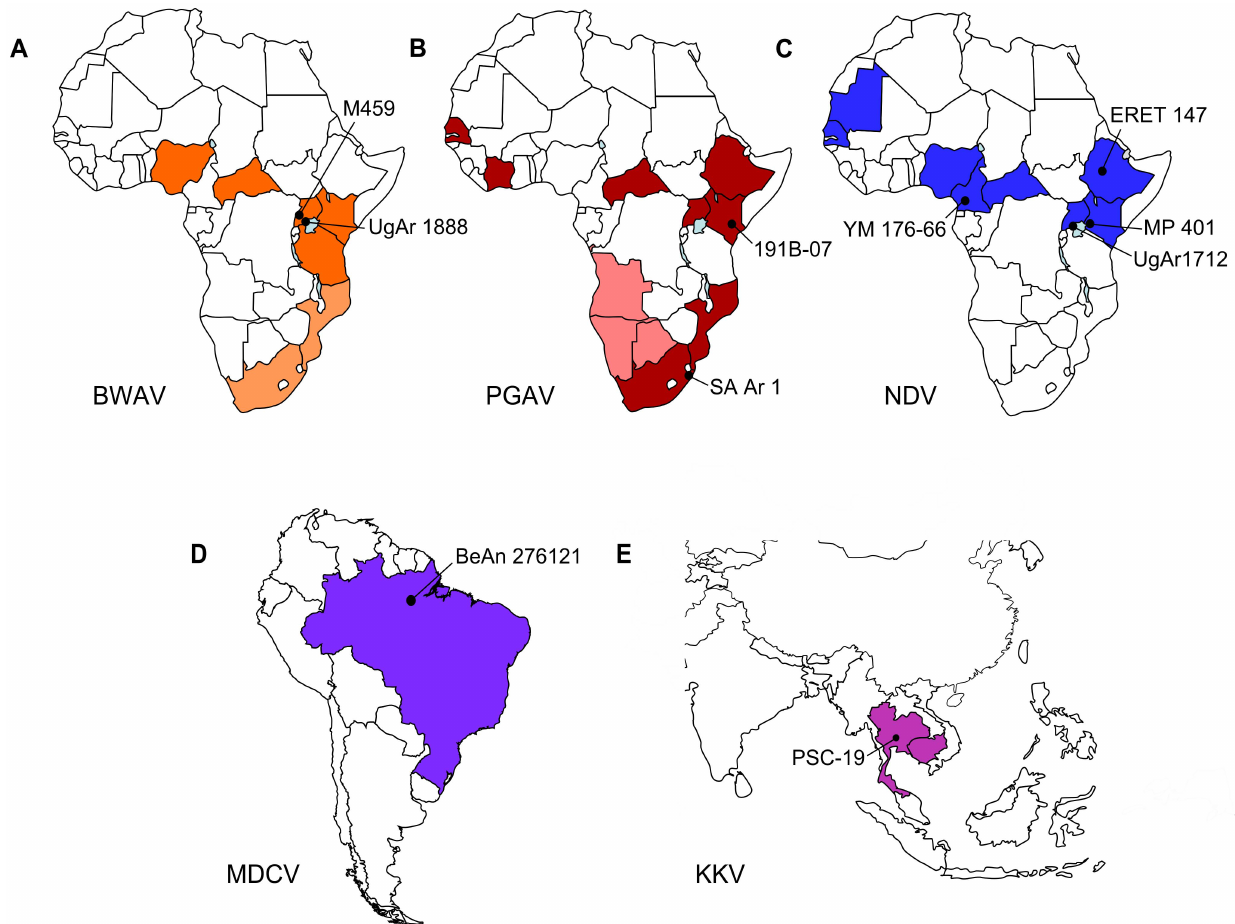
Figure 1. Geographic distribution of viruses used in this study. Distribution of (A) Bwamba virus, (B) Pongola virus, (C) Nyando virus, (D) Mojuı´ dos Campos virus, and (E) Kaeng Khoi virus. Countries in which these viruses have been isolated (dark colors) and/or where specific antibodies to these viruses have been detected (light colors) are shown in orange (BWAV), red (PGAV), blue (NDV), purple (MDCV), and pink (KKV), respectively. The geographic location from which the virus strains used in the present study were isolated, are indicated with black dots. The strain names for these isolates are also indicated.